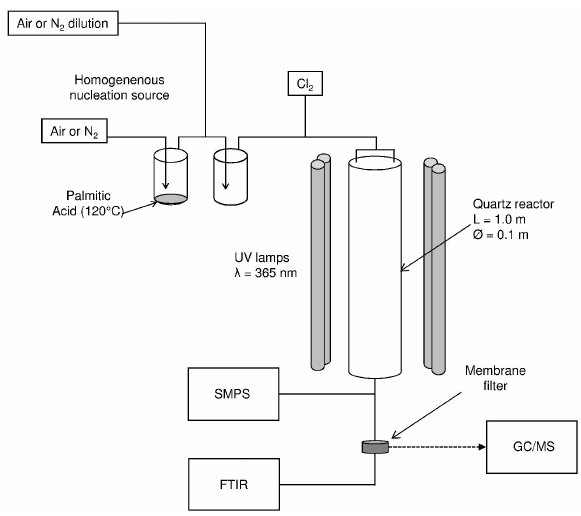
Figure 1. Experimental setup, SMPS (Scanning Mobility Particle Sizer), FTIR (Fourier 4 Fig. 1. Experimental setup, SMPS (scanning mobility particle Transform InfraRed spectrometer), GC/MS (Gas Chromatography, Mass Spectrometer) 5 sizer), FTIR (Fourier transform infrared spectrometer), and GC/MS (gas chromatography–mass 2.3 Particle generation 6 Palmitic acid particles are generated by homogeneous nucleation in a stream of 1 L min -1 N 2 7 or N 2 /O 2 flowing through a glass vessel containing 5 grams of PA. A heating wire wraps the 8 glass vessel and the PA temperature is kept constant (+/- 1°C) using a temperature controller. 9 The flow is diluted with 1 L min -1 of N 2 or N 2 /O 2 and sent to a condensation tube of 1.5 L 10 volume at room temperature. The size distribution of the particles is continuously recorded by 11 a SMPS (model TSI 3080L) every 2 minutes. Palmitic acid particle density was assumed to be 12 the solid phase density (d=0.852 g cm -3 (Lide, 2004)). Depending on the heating temperature 13